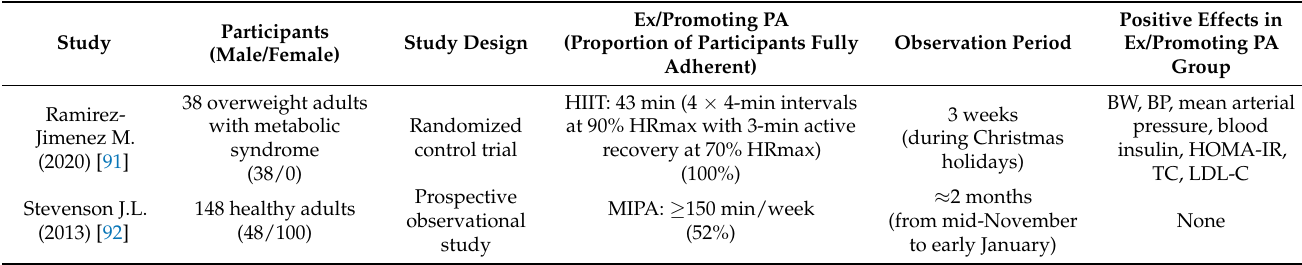
Table 1. Comparison of the influence of exercise (Ex) or promoting physical activity (PA) on seasonal variations in metabolic